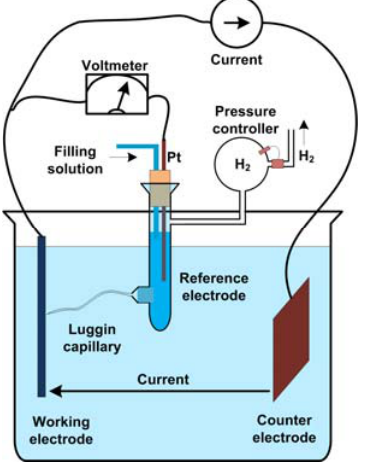
Figure 3. Three electrode setup with a standard hydrogen reference